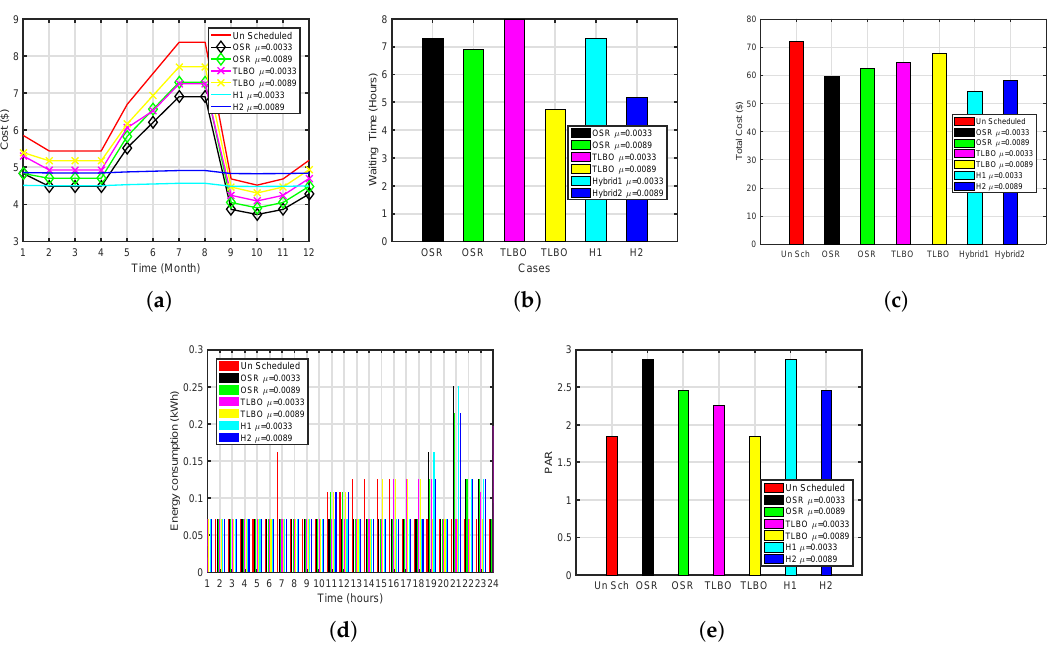
Figure 9. Hybrid Plots for Refrigerator (OSR-TLBO). ( a ) Monthly Cost of Refrigerator (OSR-TLBO), ( b ) Waiting Time of Refrigerator (OSR-TLBO), ( c ) Total Cost of Dish Washer (OSR-TLBO), ( d ) Energy Consumption of Refrigerator (OSR-TLBO), ( e ) PAR of Refrigerator